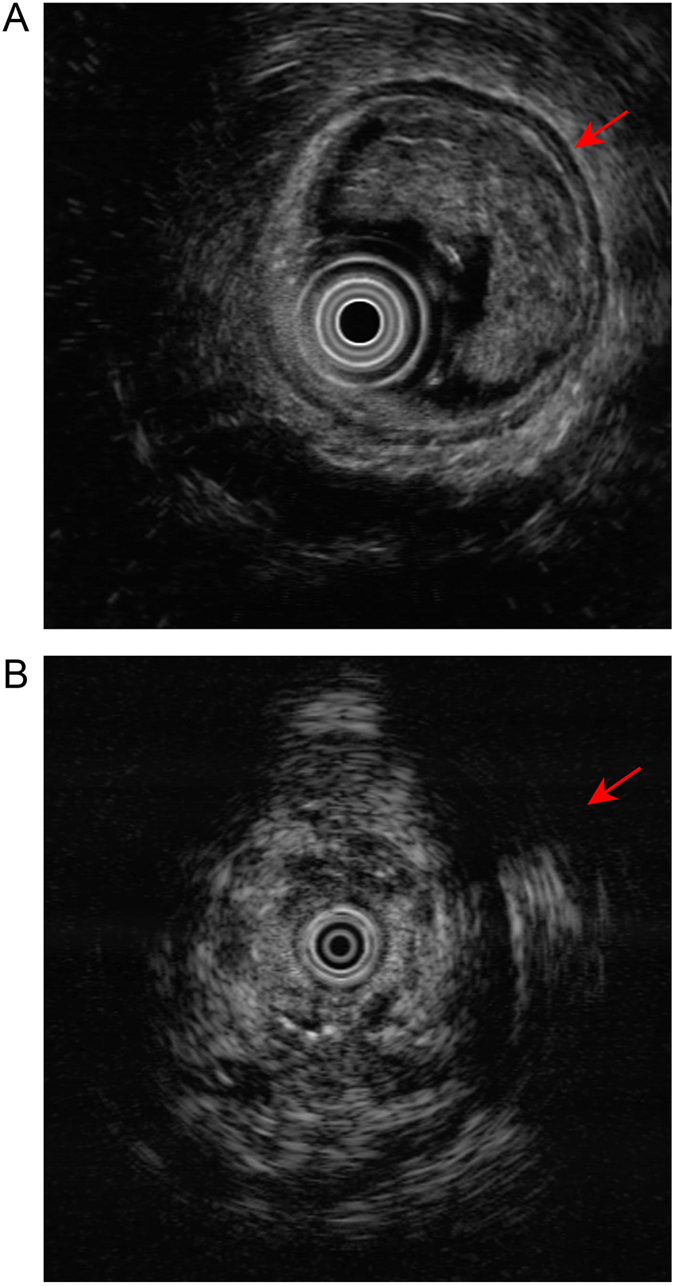
Endoscopic ultrasound images.(A) Pre-treatment; (B) Six months after radiotherapy.